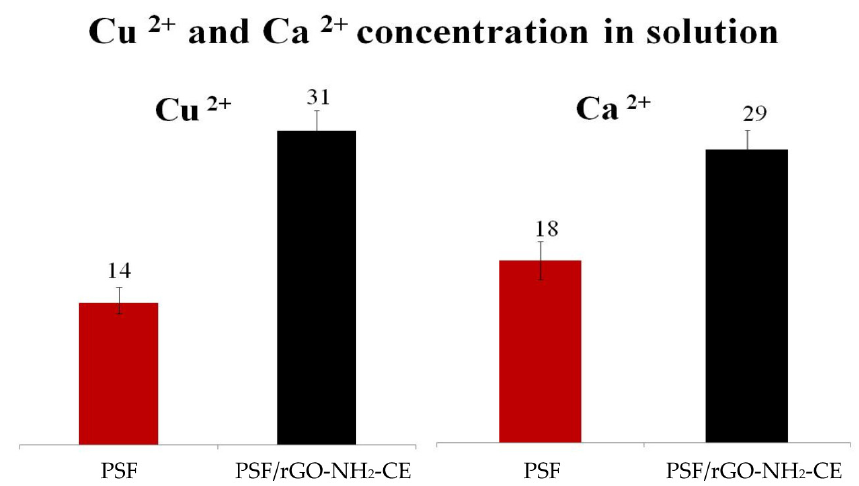
Figure 9. Graphical representation of PSF and PSF/rGO-NH 2 -CE membranes performances in terms of metal ions retention ability.